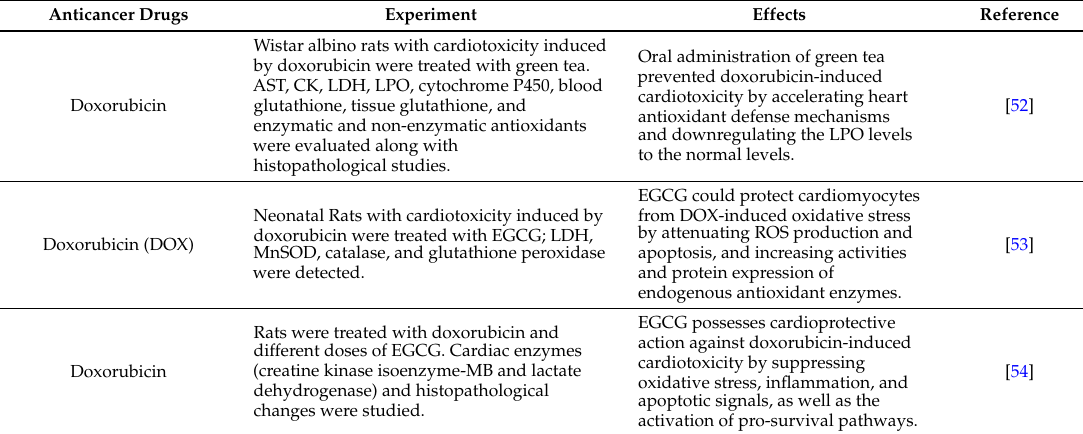
Table 2. A combination of green tea catechins and anticancer compounds ameliorating the toxicity induced by chemotherapeutic